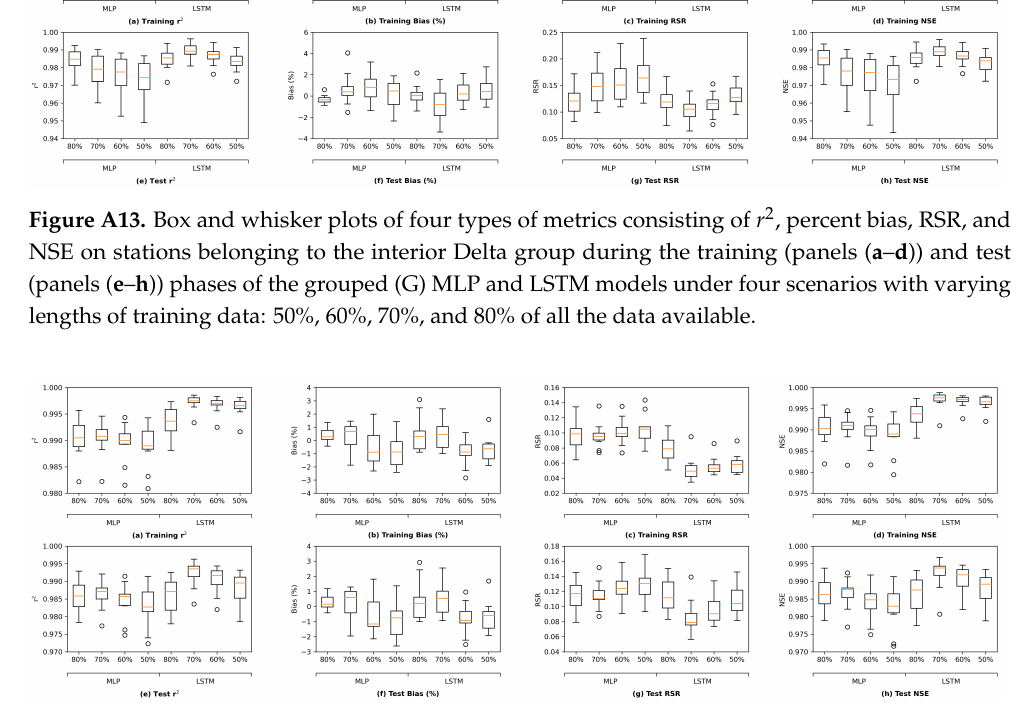
Figure A14. Box and whisker plots of four types of metrics consisting of r 2 , percent bias, RSR, and NSE on stations belonging to the western Delta group during the training (panels ( a – d )) and test (panels ( e – h )) phases of the grouped (G) MLP and LSTM models under four scenarios with varying lengths of training data: 50%, 60%, 70%, and 80% of all the data